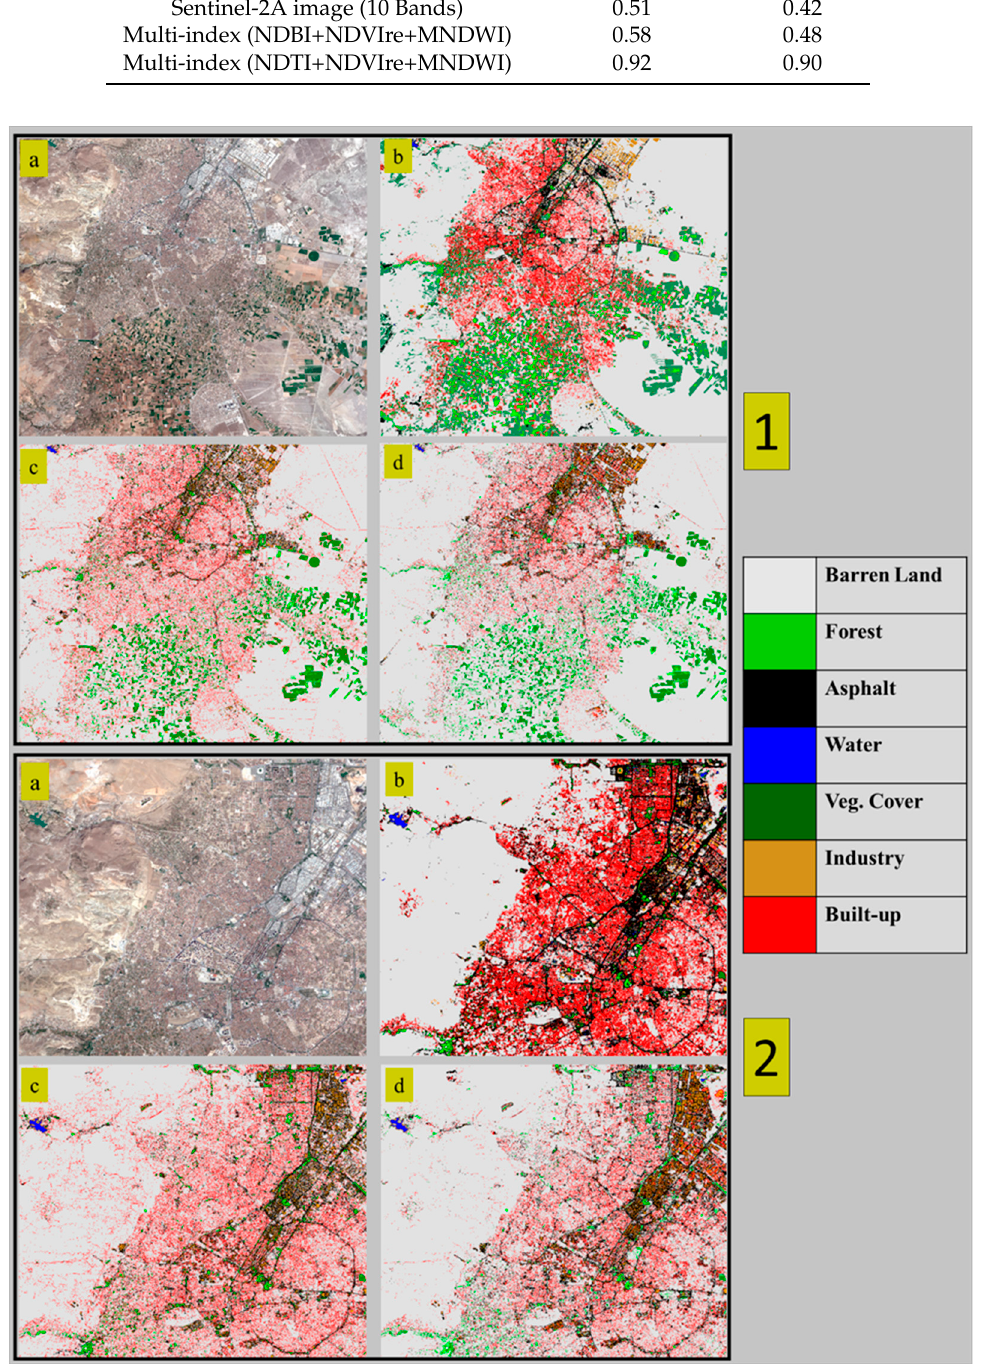
Figure 12. ( a ) RGB image of Konya from Sentinel-2A, ( b ) the classified Sentinel-2A, ( c ) the classified multi-index (NDBI, NDVIre, and MNDWI), and ( d ) the classified multi-index (NDTI, NDVIre, and MNDWI) images.